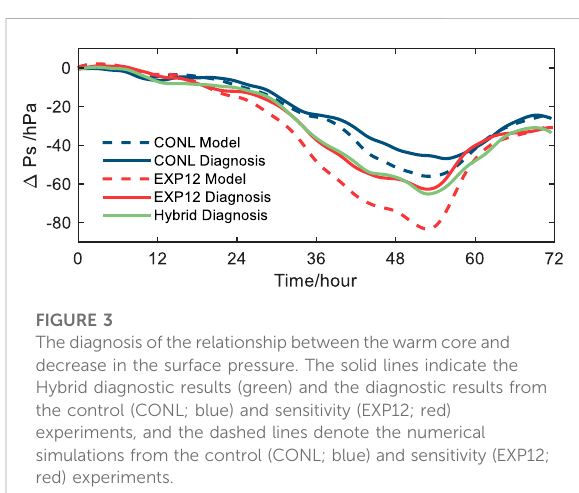
The diagnosis oftherelationship betweenthewarmcore and decrease in the surface pressure. The solid lines indicate the Hybrid diagnostic results (green) and the diagnostic results from the control (CONL; blue) and sensitivity (EXP12; red) experiments, and the dashed lines denote the numerical simulations from the control (CONL; blue) and sensitivity (EXP12; red)